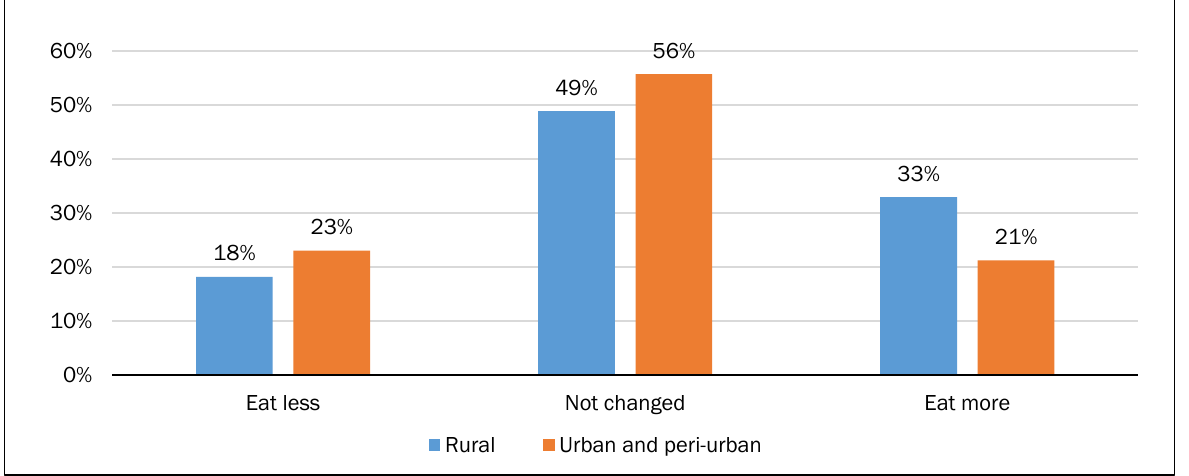
Figure 2. Changes in Food Consumption Patterns in Rural, Urban, and Peri-urban Areas of Eastern Africa During the COVID-19 Pandemic,